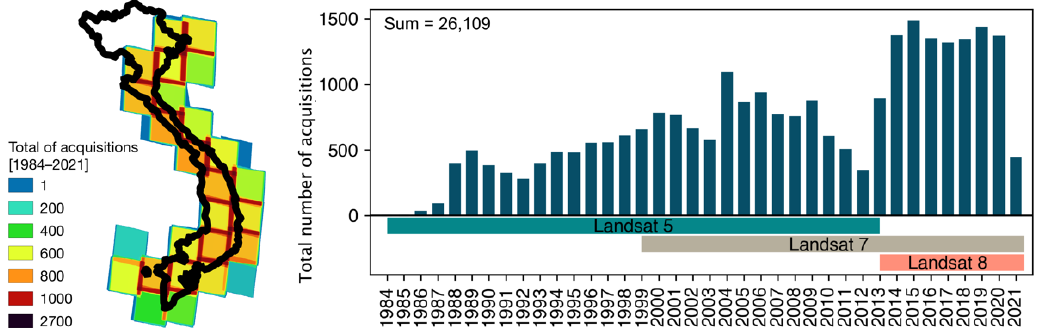
Figure 2. Spatio- temporal distribution of Landsat acquisitions for Vietnam’s coastal zone , 1984 – Figure 2. Spatio-temporal distribution of Landsat acquisitions for Vietnam’s coastal zone, 1984–2021. 2021.